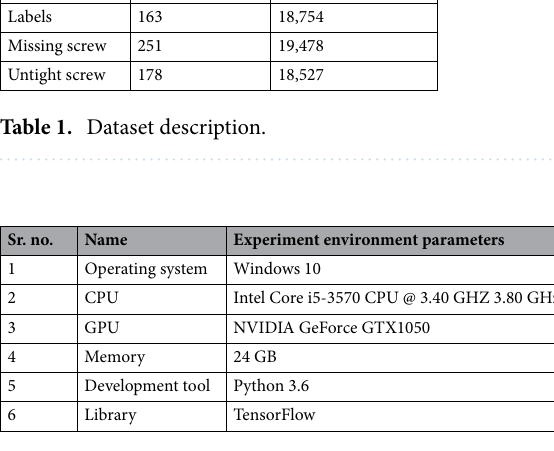
Table 2. Detailed environment parameters which are used for implementation.